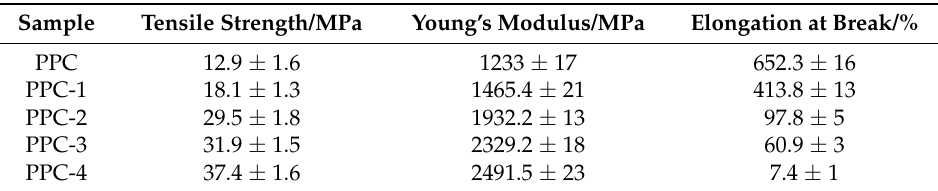
Table 3. The mechanical properties of PPC and PPC with